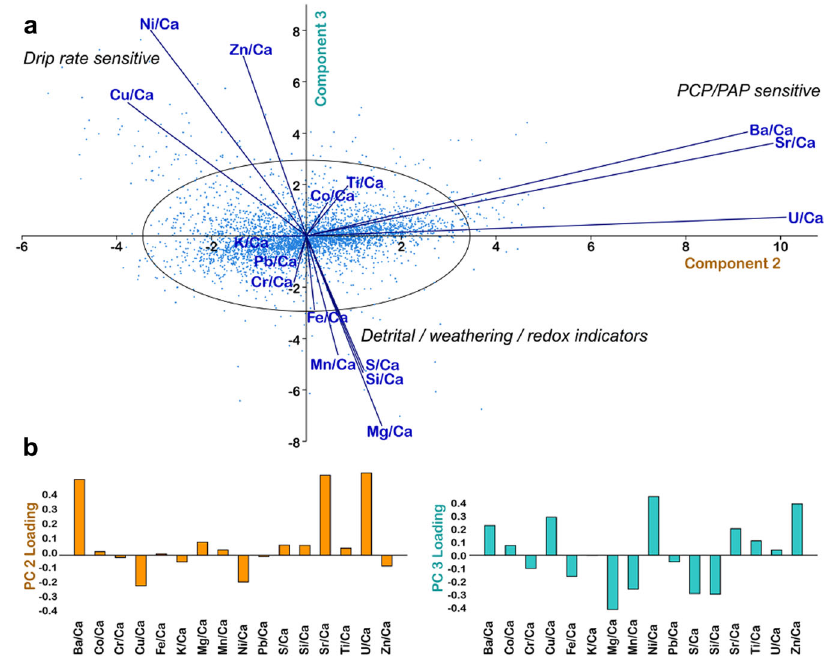
Fig. 3 Principal component analysis from 4.2-3.1 ka BP. a Principal components 2 and 3 of the LA-ICP-MS dataset for the aragonite-only bottom half of DHAR-1B (4.2 – 3.1 ka BP) with a 95% con fi dence ellipse (black circle), showing distinct groups of the drip-rate-sensitive transition metals Ni, Zn, and Cu, the PAP-sensitive trace elements Ba, Sr, and U, and the redox-related trace elements of Fe, S, Cr, and Mn. b Loadings for PC2 (12.4% of variance) and PC3 (9% of variance). Statistics were calculated and the fi gure was generated using PAST 4.10 software 87 . Note that PC1 (28.8% of variance) is not shown — the loadings indicate a dominance of U/Ca over other elemental